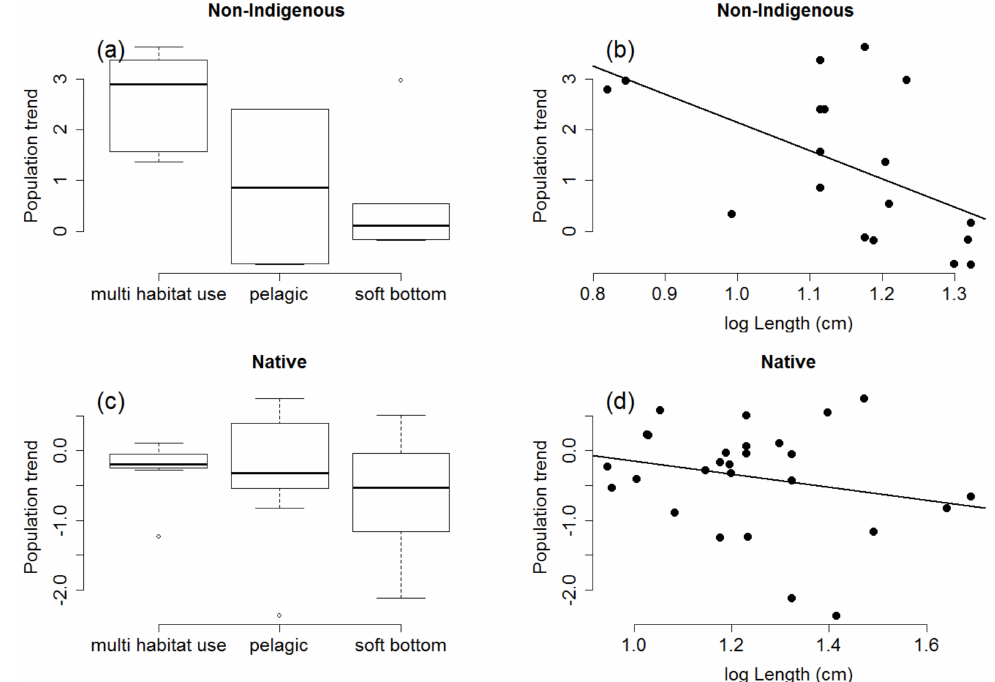
Figure 1. Relationship between population trends and the major identified traits for non-indigenous (top) and native (bottom) species. Left panels ( a , c ) show the relationship with habitat affinity and right panels ( b , d ) the relationship with length at first maturity. Lines in the right panel indicate ordinary least squares regression